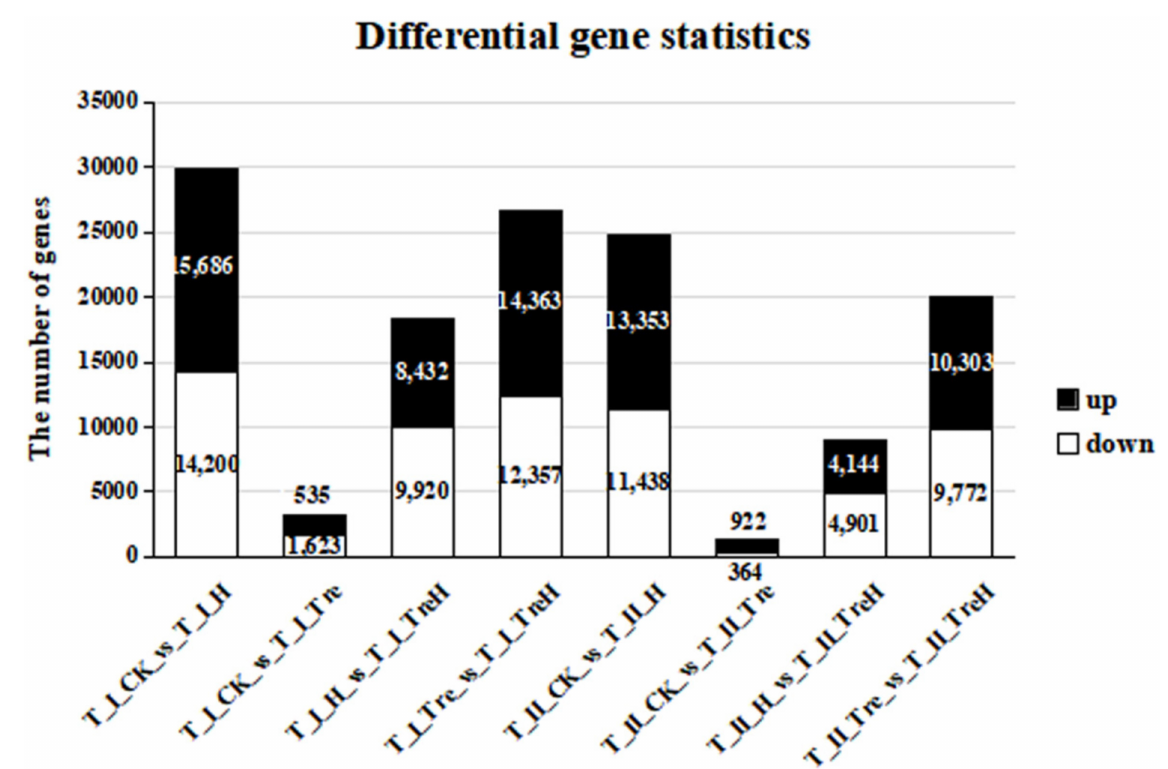
Figure 5. Differential gene statistics. T—the transcriptome; I—Yangmai 18; II—Yannong 19; CK—control group; H—heat stress treatment for 24 h; Tre—trehalose pretreatment for 3 d; TreH—trehalose pretreatment for 3 d followed by high-temperature treatment for 24